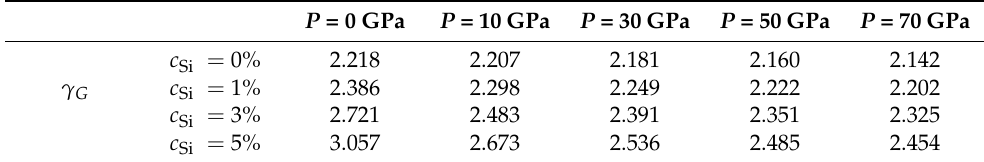
Table 6. Si concentration and pressure dependence of the Gruneisen parameter γ G . for WSi at T = 300 K.